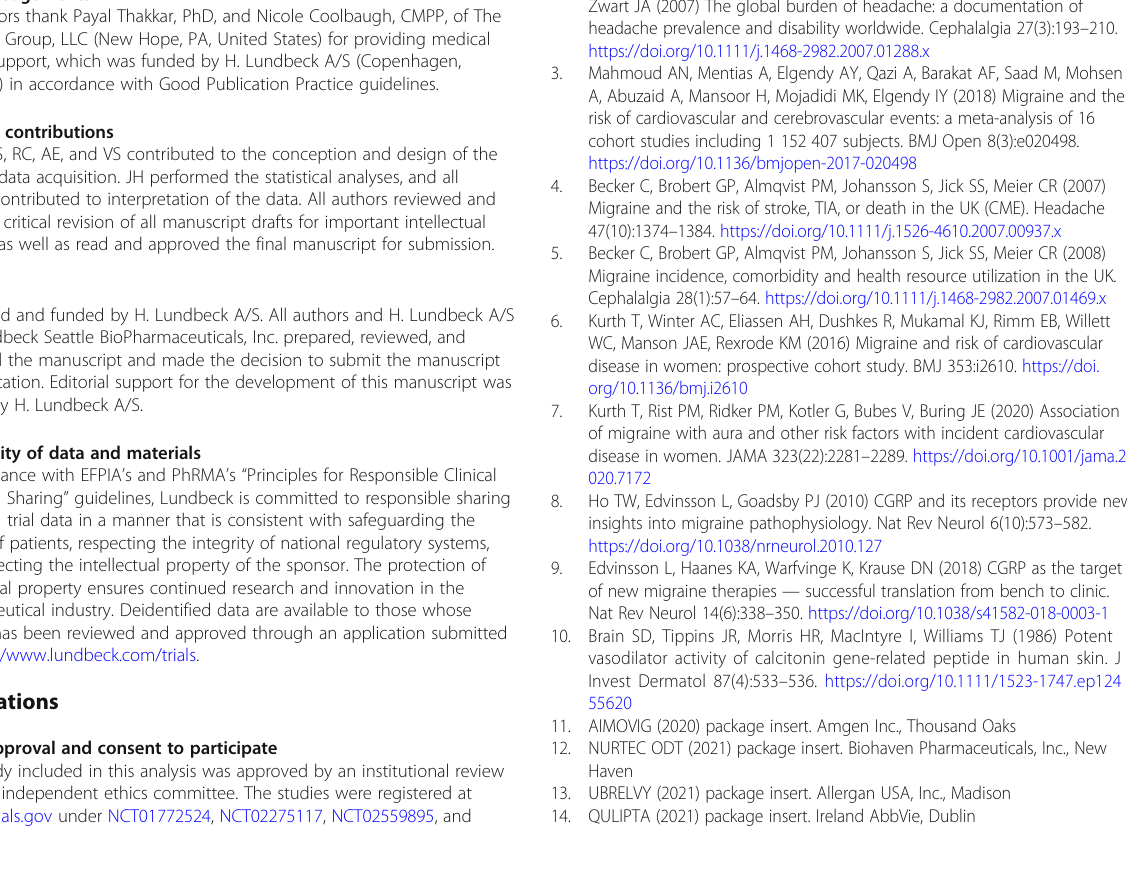
Additional file 1: Supplemental Table 1. Study Drug Discontinuation and Infusion Interruption Due to Cardiovascular Treatment-emergent Ad- verse Events Across the Pooled Eptinezumab Clinical Trial Population. Supplemental Table 2. New or Changed Cardiovascular Concomitant Medications Across the Pooled Eptinezumab Clinical Trial